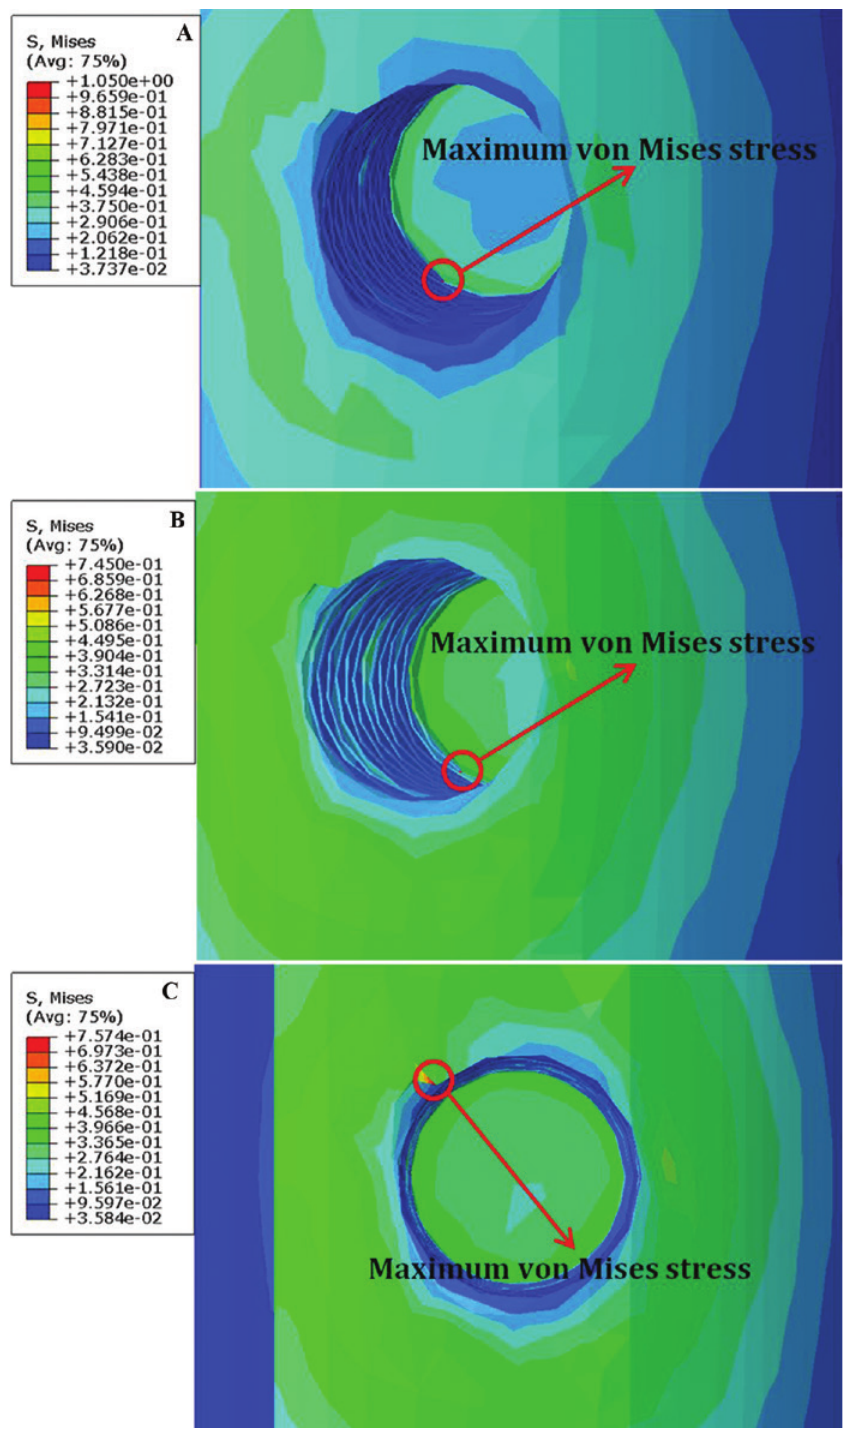
= 40), and (C) SFGM ( η = 10) out